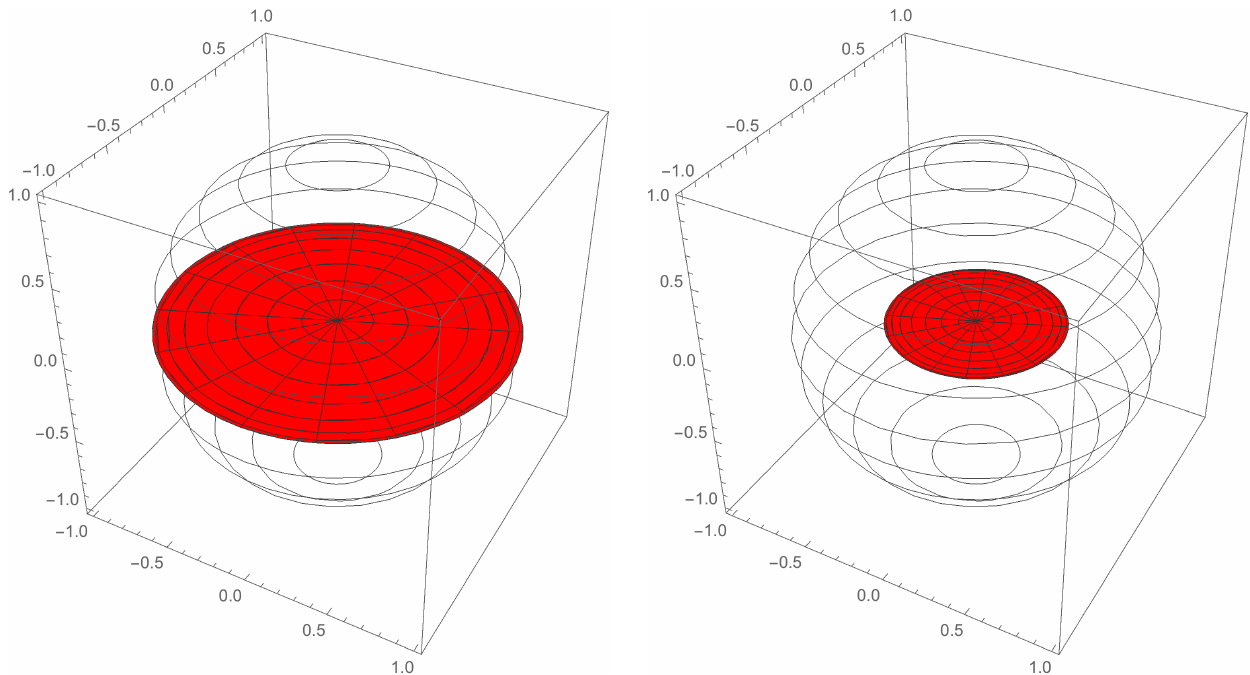
Figure 5: Action of the not completely positive (NCP) pancake map. The Bloch ball (outer ball of unit radius) is shown in white. The image is plotted in red.